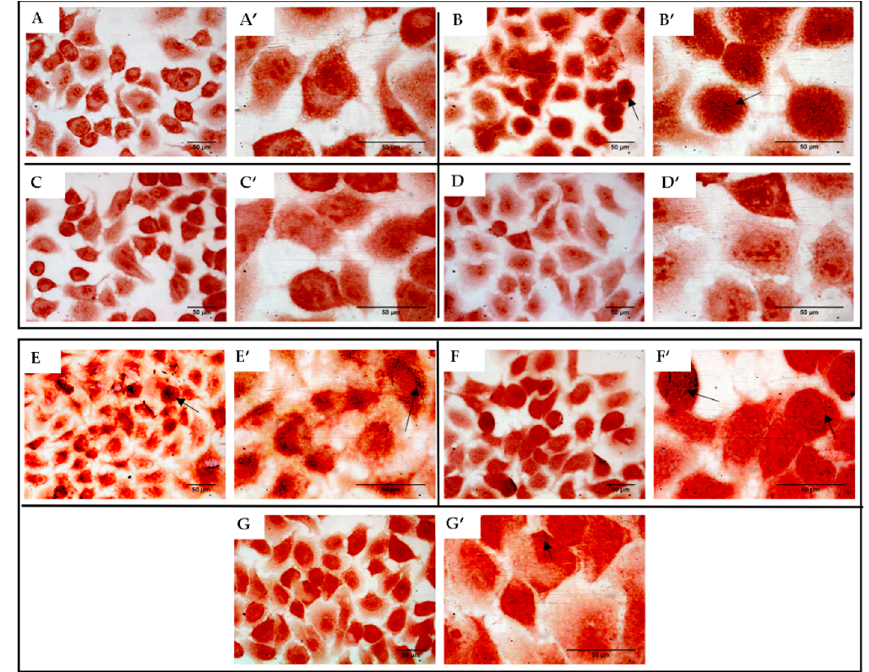
Figure 8. S. aureus ATCC 6538 (B–D) and MRSA 8 (E–G) adhesion to human lung A549 cells visualized using Gram staining. Bacterial adhesion, in the different experimental conditions, was compared to negative control ( A ). (40 × magnification A–G; 100 × magnification A’–G’). ( A , A’ ): uninfected cells (negative control); ( B , B’ ): A549 cells infected with S. aureus ATCC 6538 (positive control); ( C , C’ ): A549 cells infected with S. aureus ATCC 6538 and simultaneously treated with 32.00 µ g/mL of K. lappacea root extract (KLRE); ( D , D’ ): A549 cells infected with S. aureus ATCC 6538 and simultaneously treated with 64.00 µ g/mL of KLRE; ( E , E’ ): A549 cells infected with MRSA 8 (positive control); ( F , F’ ): A549 cells infected with MRSA 8 and simultaneously treated with 32.00 µ g/mL of KLRE; ( G , G’ ): A549 cells infected with MRSA 8 and simultaneously treated with 64.00 µ g/mL of KLRE. Adherent colonies of S. aureus to A549 cell surface (black arrows).